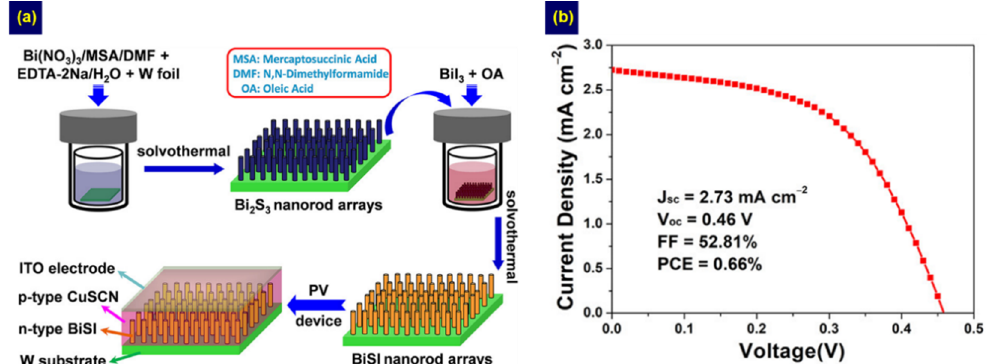
Figure 6. BiSI nanorods array fabrication from Xiong et al. [49] showing: ( a ) a schematic diagram of the BiSI nanorod arrays fabrication procedure and ( b ) a typical current density–voltage curve of n ITO/CuSCN/BiSI/W device. Adapted with permission from ACS Sustainable Chem. Eng. 2020 , 8 , 13488–13496. Copyright 2020 American Chemical Society [49].